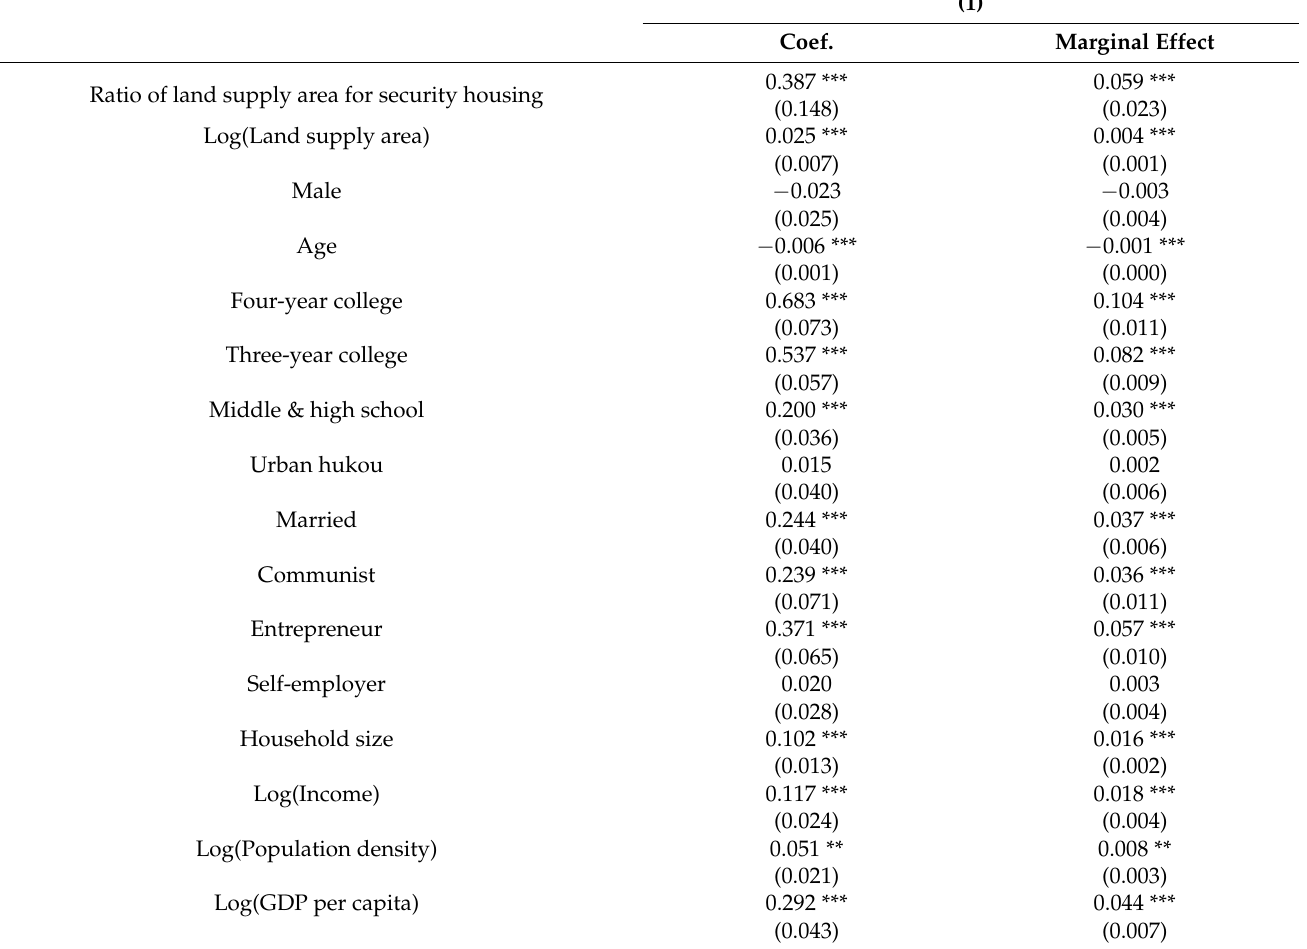
Table A1. Estimated results of housing security and settlement intentions (Logit